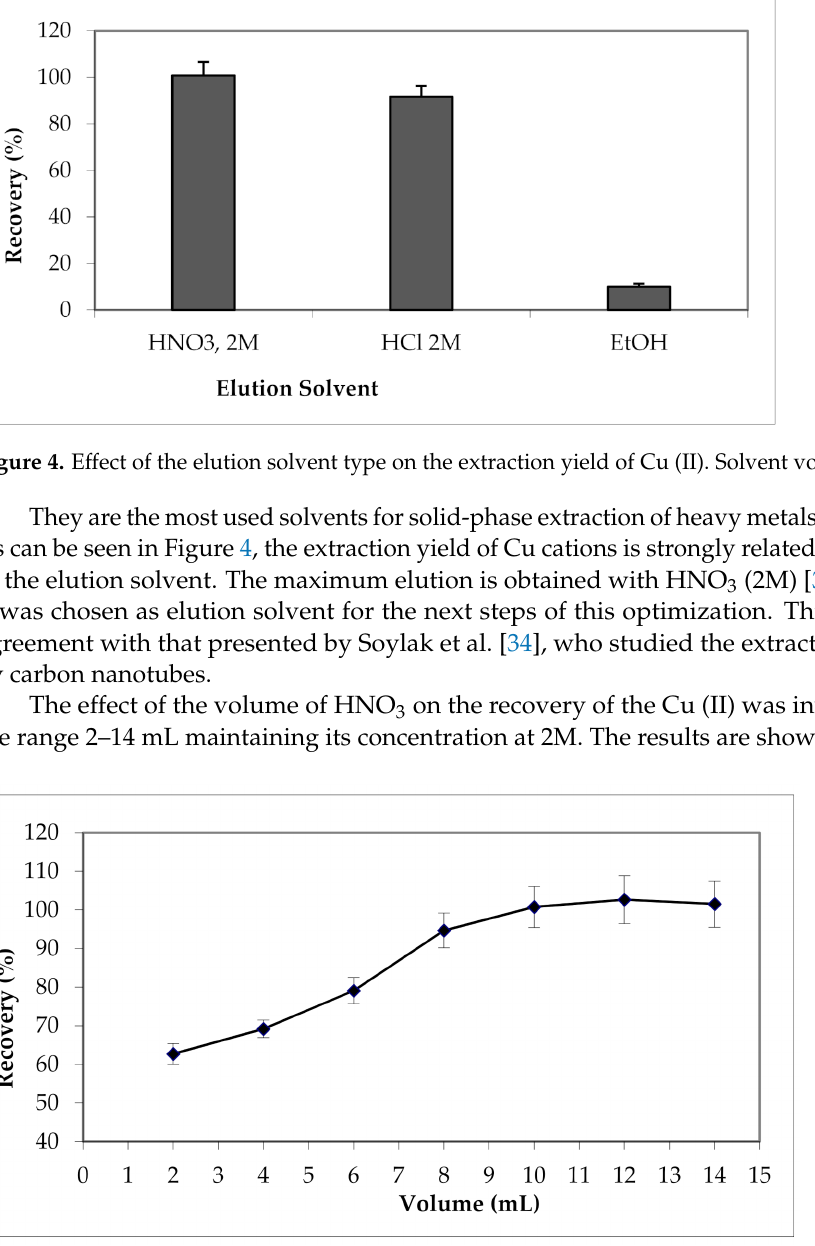
Figure 5. Effect of HNO 3 volume on Cu (II)